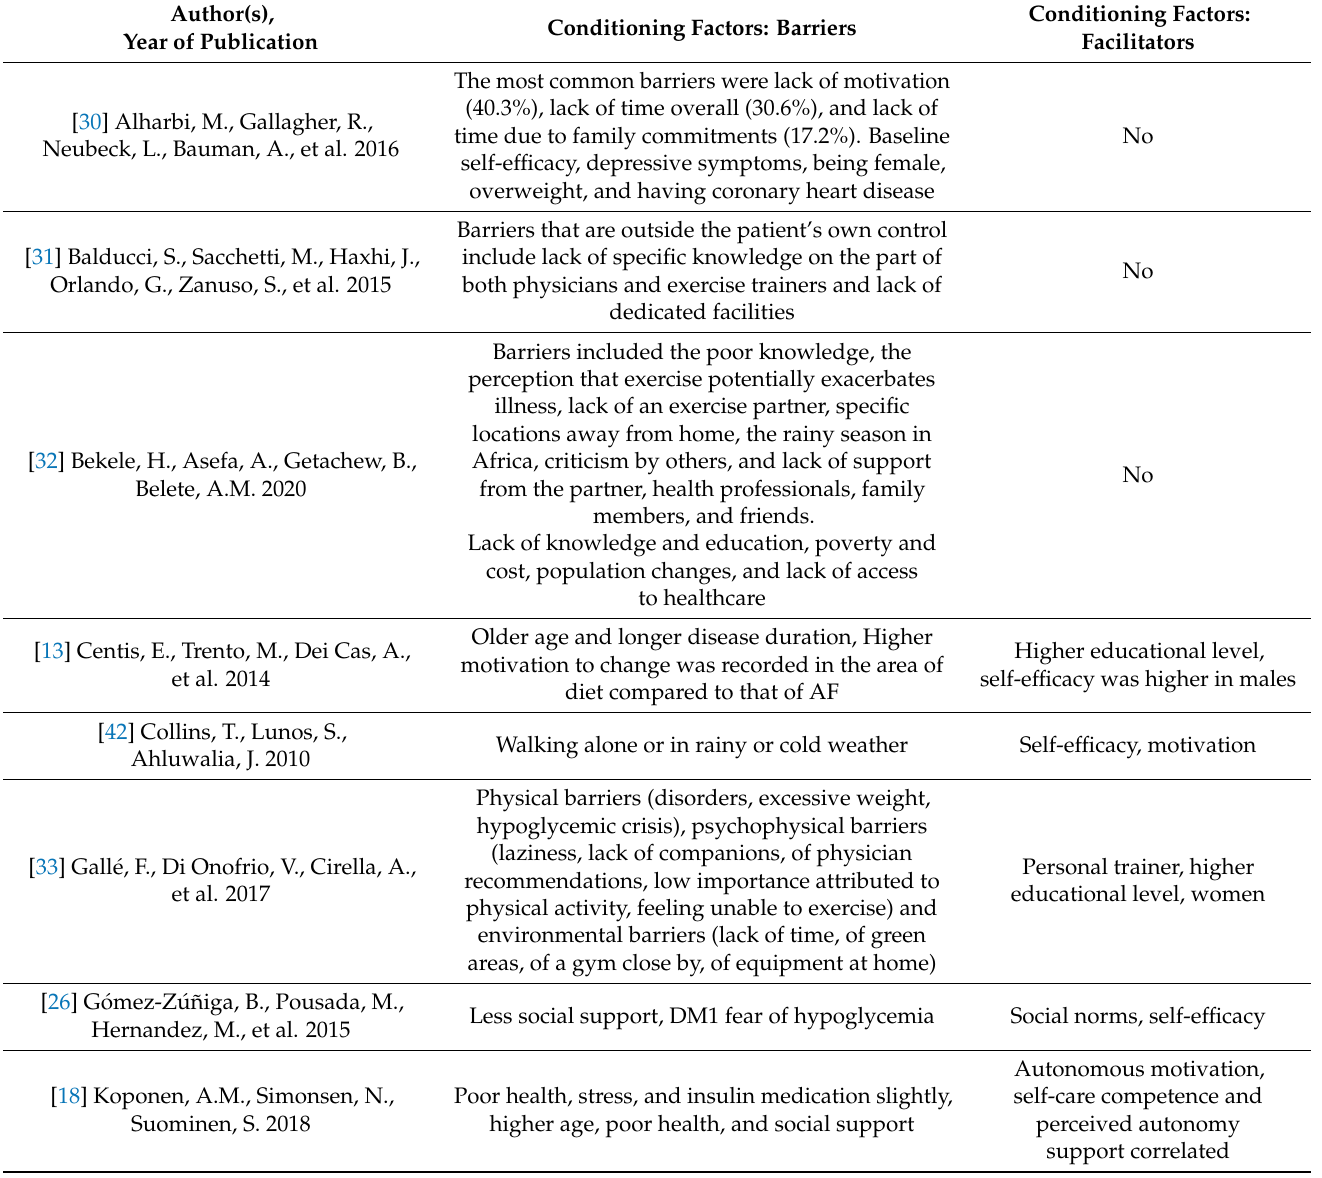
Table 3. Barriers to, and facilitators of, the performance of